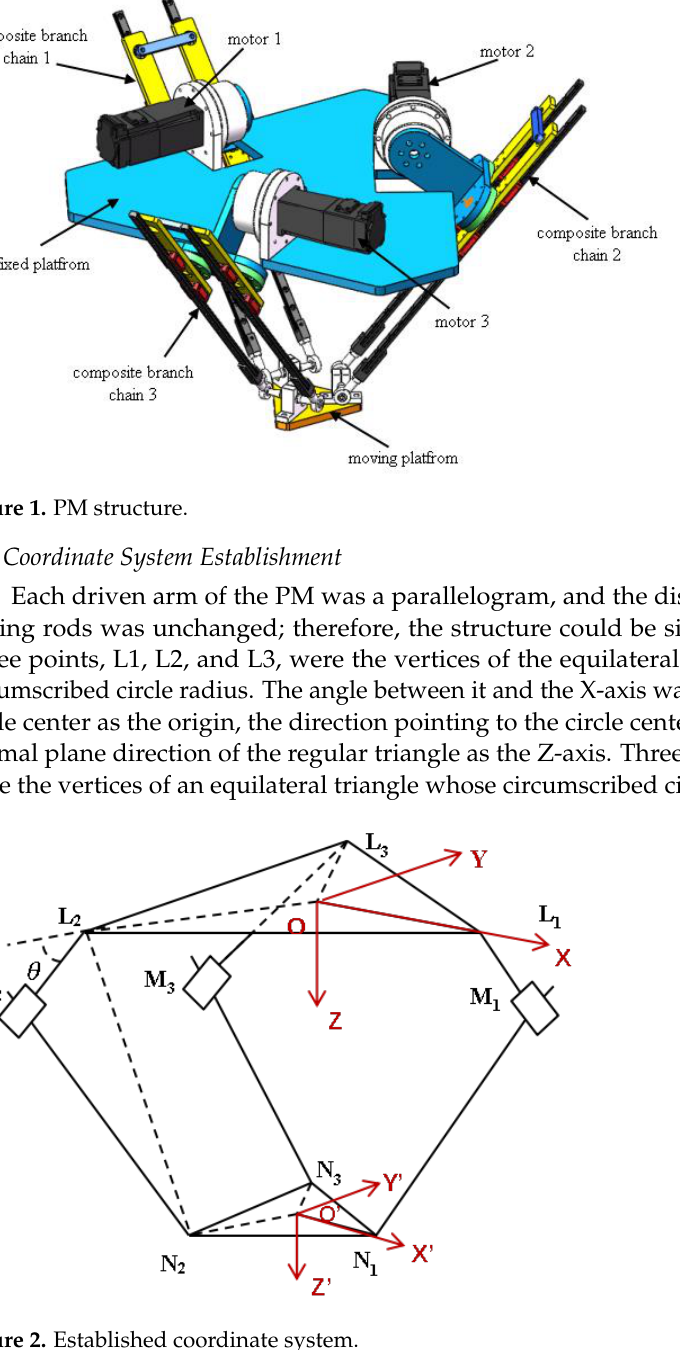
Figure 2. Established coordinate system .